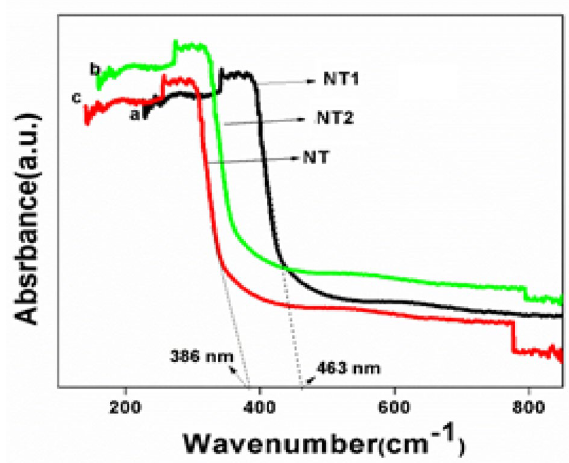
Figure 5. UV–Vis spectra of templated samples.